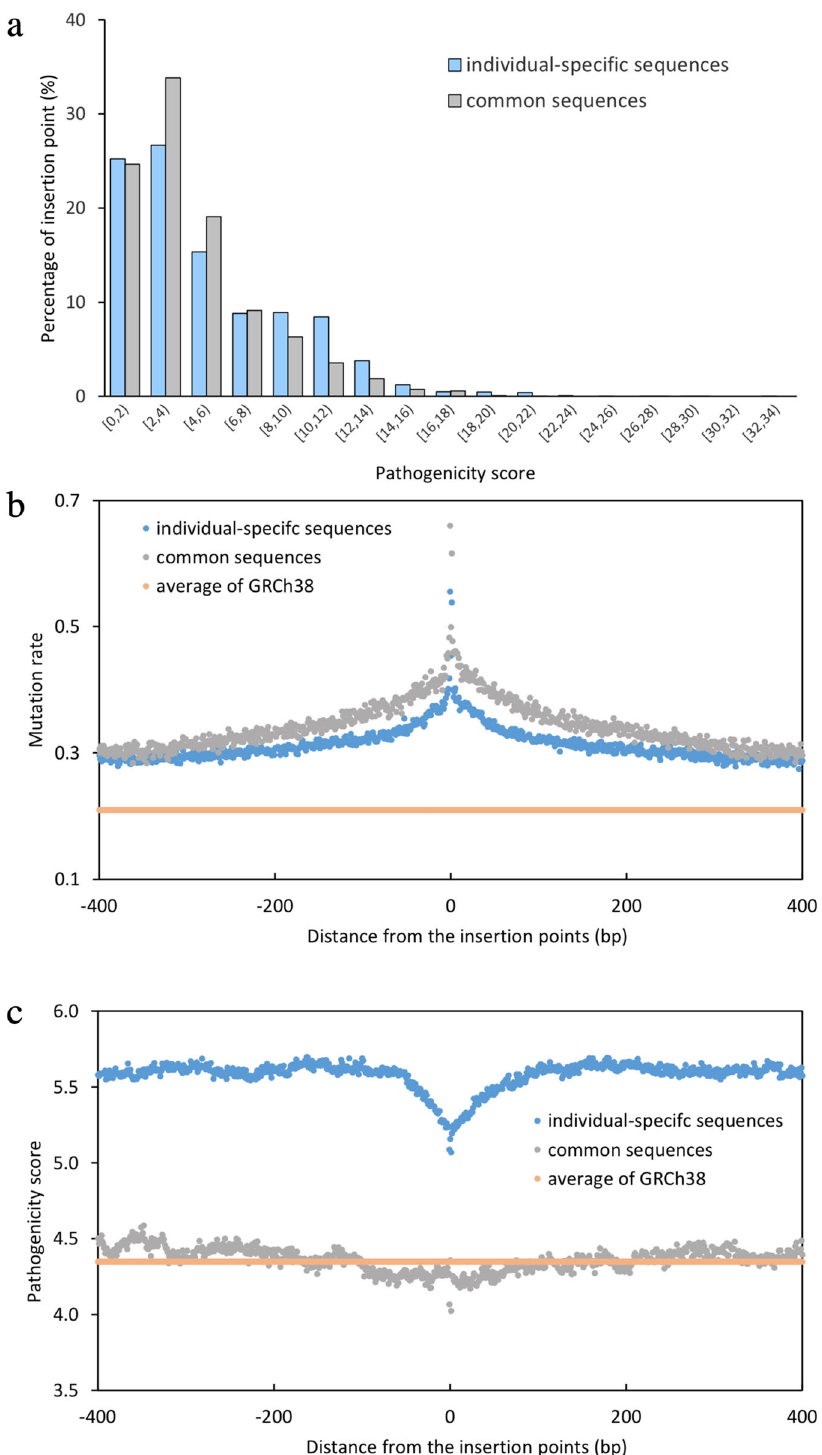
Fig. 4 Characterizations of the common sequences and insertion points. a The percentages of the insertion points of the common and individual-speci fi c sequences in each binning of pathogenicity scores. b The mutation rate in the 500 bp fl anking region of insertion points. c The pathogenicity score in the 500 bp fl anking region of insertion points. The average pathogenicity score was calculated using GRCh38 data. The average pathogenicity scores of the insertion regions of common and individual-speci fi c sequences were calculated (see “ Methods ”